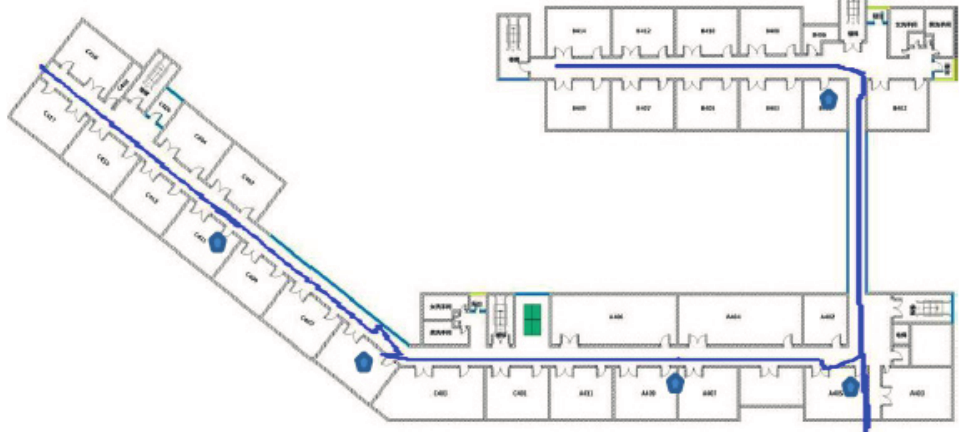
Figure 11. PDR-based positioning method based on map matching with Bluetooth-based position